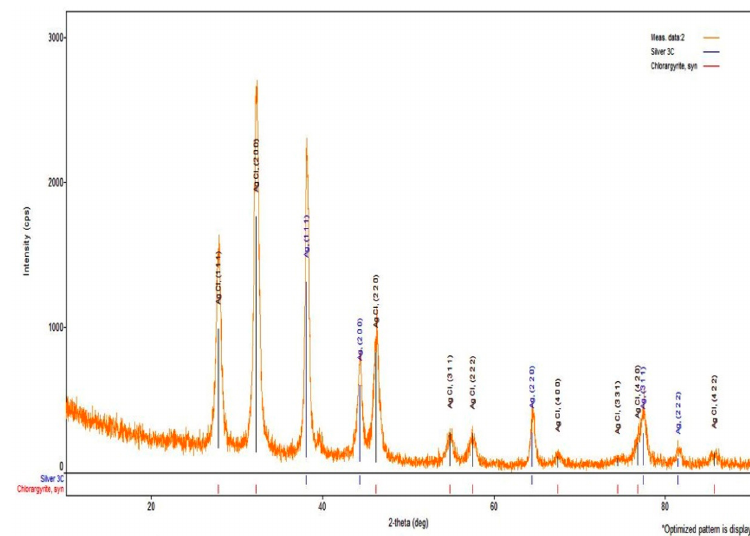
Fig. 5. X-Ray Powder Diffraction (XRD) of crude silver nanoparticles